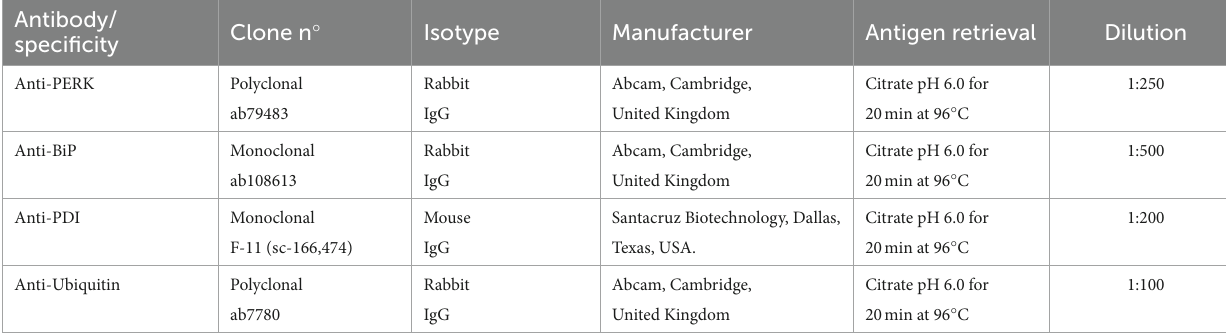
TABLE 1 Immunohistochemical protocols used for ER stress markers detection. Antibody/